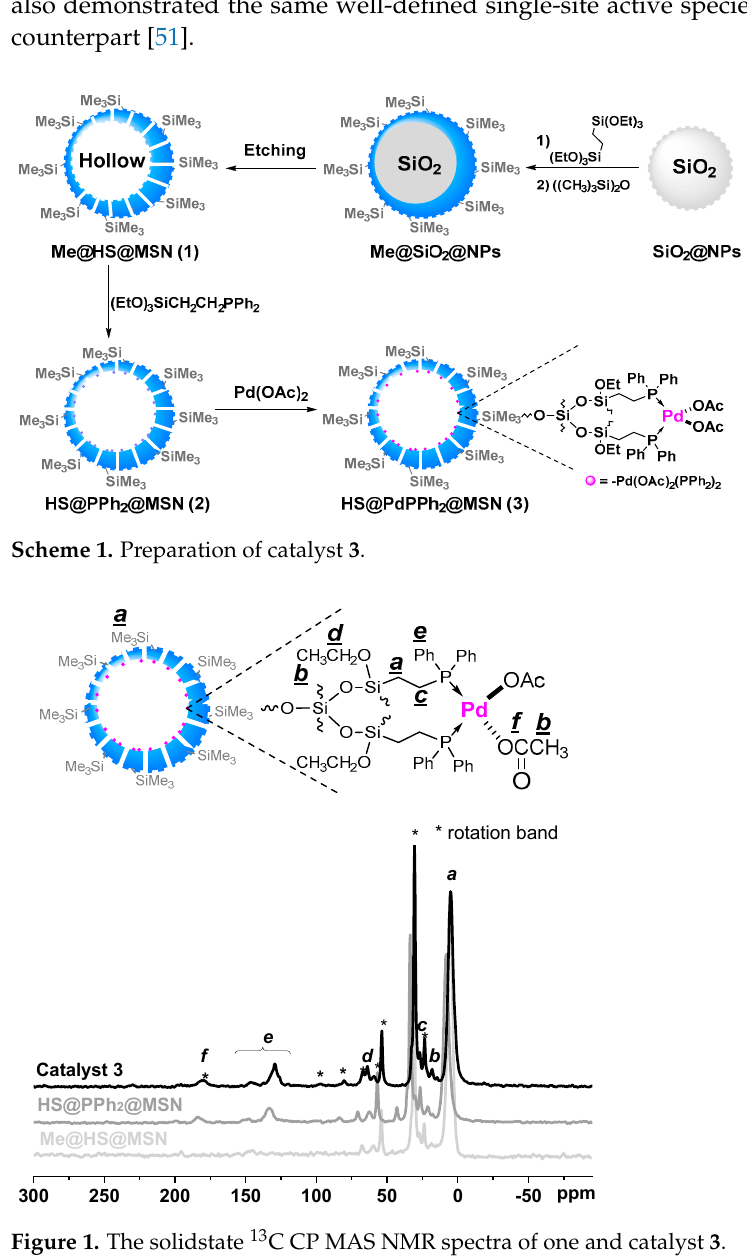
Figure 1. The solidstate 13 C CP MAS NMR spectra of one and catalyst 3 . Q 2 Figure 3. The solid-state 29 Si MAS NMR spectrum of catalyst 3 . The morphology and ordered mesostructure of three were further investigated by scanning electron microscopy (SEM), transmission electron microscopy (TEM), and nitro- gen adsorption-desorption measurements. As shown in Figure 4, the nitrogen adsorption- desorption isotherm of three showed a typical type IV isotherm with an H 1 hysteresis loop and a visible step at P / P 0 = 0.45–0.95 demonstrating its mesoporous structure. The pore size distribution of catalyst 3 revealed that it had uniform mesopores of about 6.3 nm (see Supplementary Information in Figure S3), which were similar to that of the corresponding pure Me@HS@MSN and HS@PPh 2 @MSN materials, except for the reduced surface area (64.72 m 2 /g for HS@PPh 2 @MSN, 51.23 m 2 /g for catalyst 3 , versus 74.72 m 2 /g for Me@HS@MSN), and pore volume (0.14 cm 3 /g for HS@PPh 2 @MSN, 0.08 cm3/g for catalyst 3 , versus 0.17 cm 3 /g for Me@HS@MSN) suggesting that the decoration of the PPh 2 and the complexation of Pd with PPh 2 led to nanopore narrowing in catalyst 3 . Figure 5 presented the hollow-shell-structured morphology of catalyst 3 . Its SEM images showed that the nanospheres were uniformly dispersed; its average particle size was ~445 nm (Figure 5a). The TEM images were also collected and showed that each nanosphere had a cavity of